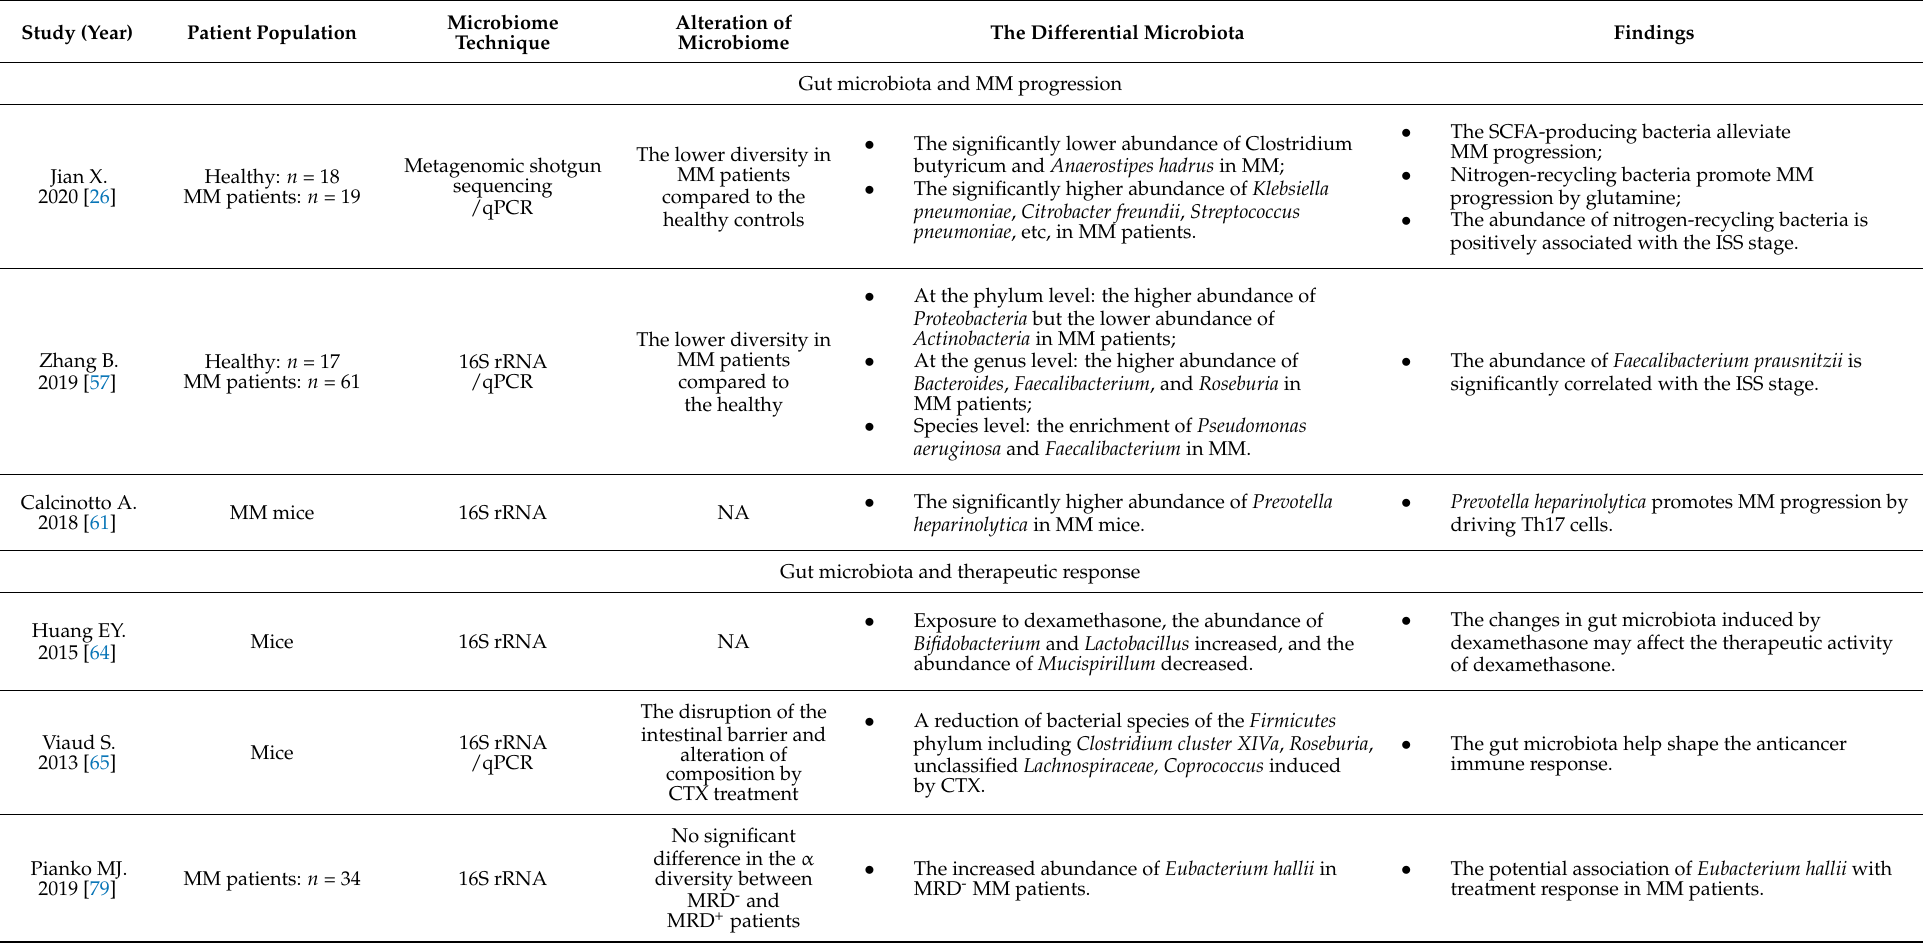
Table 1. Studies of the gut microbiome in multiple